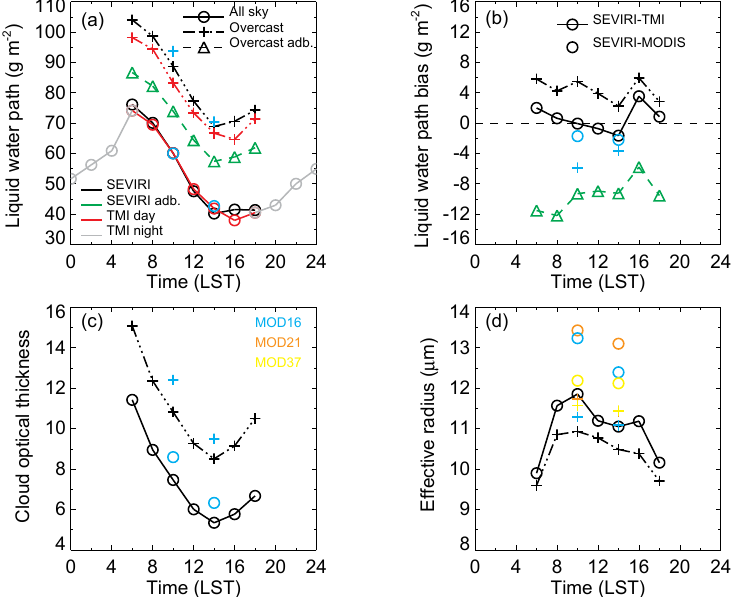
Figure 9. The 2-year-mean diurnal cycle of cloud properties over the Sc region, both for all-sky and overcast (LCF ≥ 95% and τ > 3) cases: (a) SEVIRI and TMI LWPs, (b) SEVIRI minus TMI LWP bias, (c) SEVIRI τ , and (d) SEVIRI 1.6µm r e . MODIS Terra and Aqua values are also plotted. Rain-, ice-, and smoke-free conditions were applied.